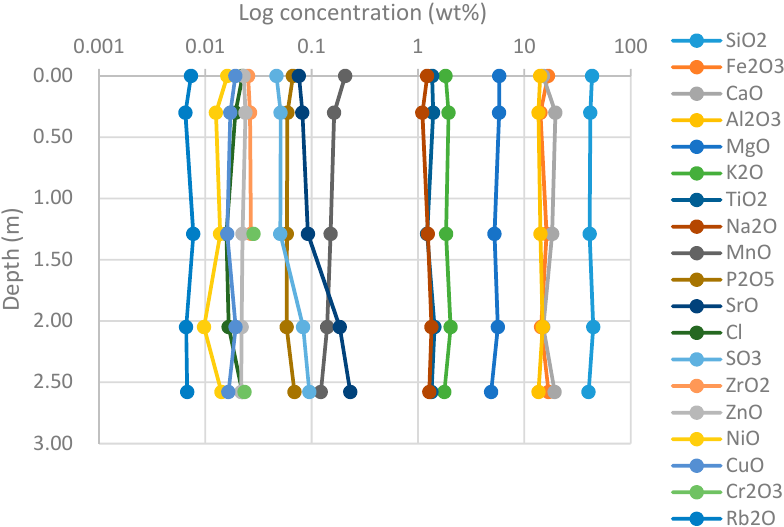
Figure 7. XRF data for bentonite in borehole KM2 (normal-log plot). All depths are from the base of the overlying limestone.